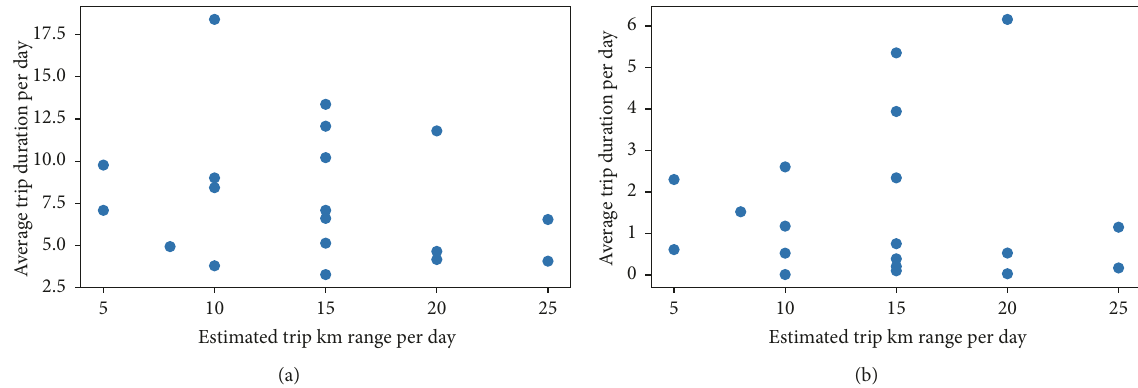
Figure 7: Actual riding behaviour compared to the estimated behaviour. Both figures show the average duration of a trip. (a) plots trips in summer (May–October), while (b) shows trips in winter (November to